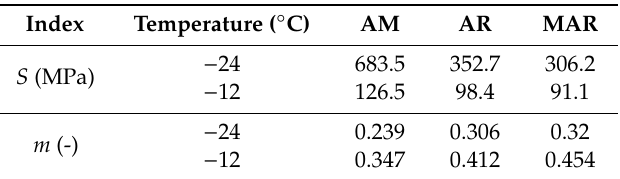
Table 6. BBR tests